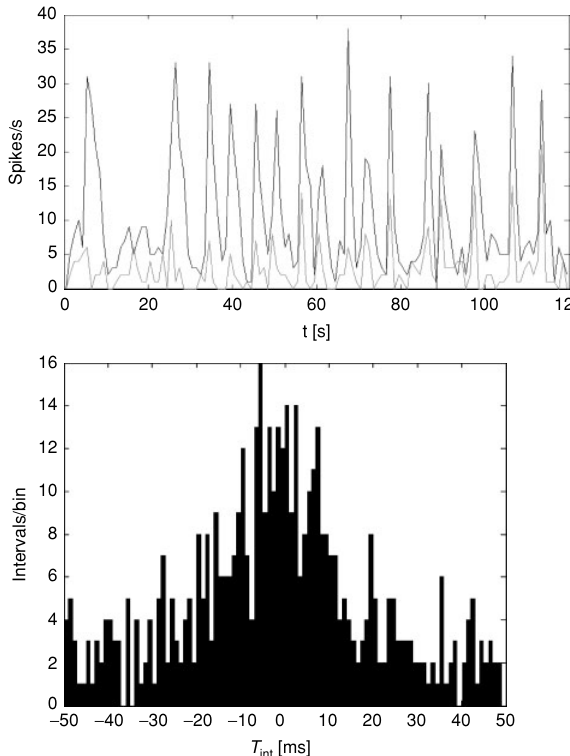
Figure 6 Analysis of the spike activity of the two connected islands at electrodes e34 and e40 of Fig. 6. Top: spikes/s during 120 s of bursting period. Vertical scale: spikes/s. The two curves are for electrode 34 (upper, dark gray curve) and 40 (light gray). The two curves clearly resemble the same oscillating pattern of bursts, pointing at synchronization between the two networks. Spearman correlation coefficient is: ρ = 0.61. Below: Inter electrode (same electrodes 34 and 40) interval time ( T int ) histogram, bin-width is 1 ms. This second representation of the same data also illustrates clearly synchronization between the firing patterns of the two island